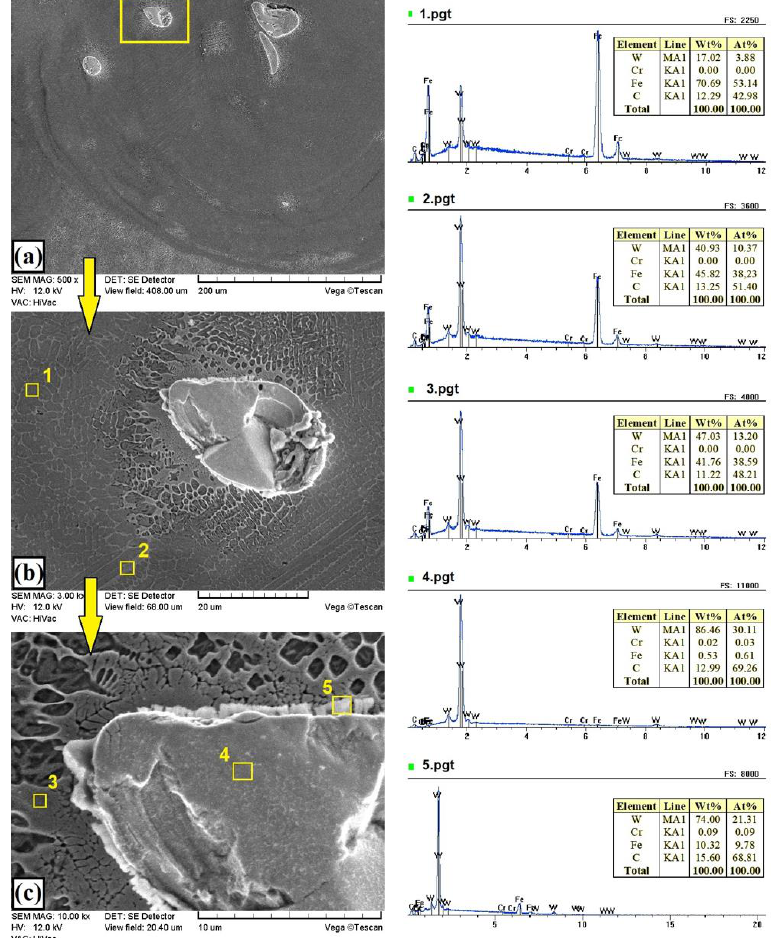
Figure 9. Microstructure and EDS point analysis of coating formed using 100% WC particles produced using laser processing of precoat applied on steel substrate: ( a ) general view of the melting zone; ( b ) selected carbide; ( c ) carbide-matrix